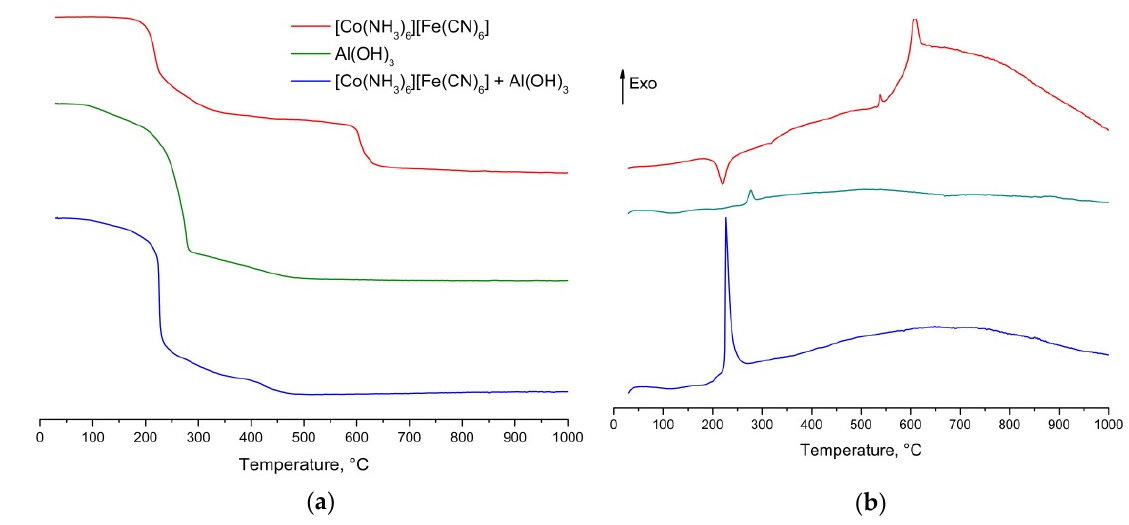
Figure 1. Thermal analysis curves for [Co(NH 3 ) 6 ][Fe(CN) 6 ], Al(OH) 3 and mixtures thereof: ( a ) TG, ( b ) DSC. The characteristics of the investigated catalytic compositions were shown in Table 1.